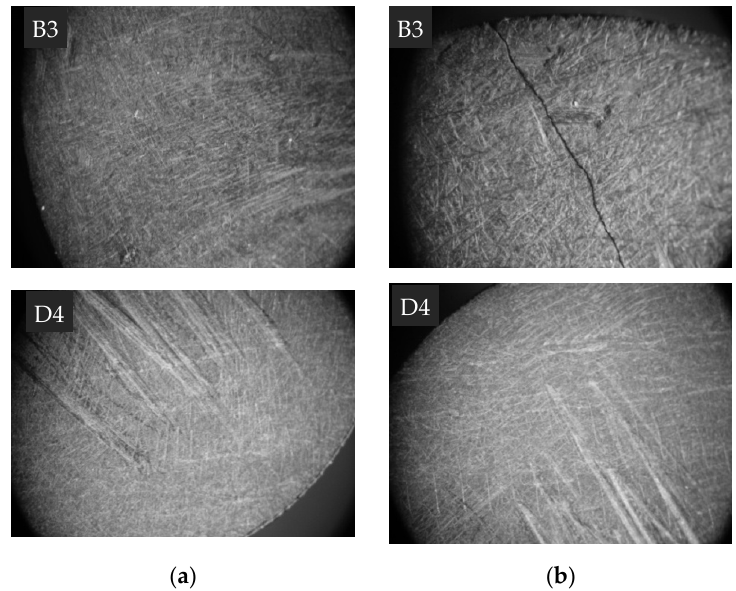
Figure 6. Photos of the microstructure of samples B3 and D4 ( a ) before the treatment and ( b ) after the radio-frequency treatment (48× magnification).